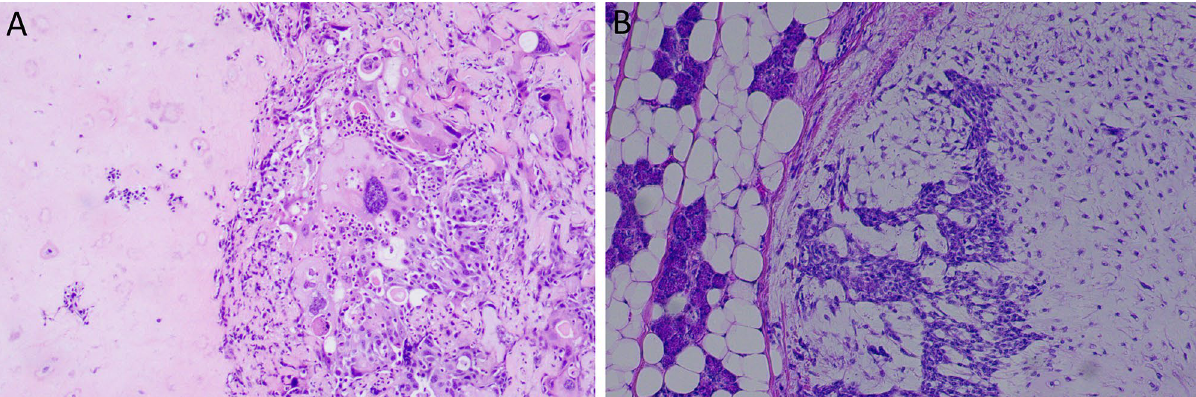
Figure 2. ( A ) Nuclear atypia and chondroid tissue formation in CxPA Magnification ×200. ( B ) Myxoid stroma and capsuled PA surrounded by healthy parotid tissue. Magnification ×100.